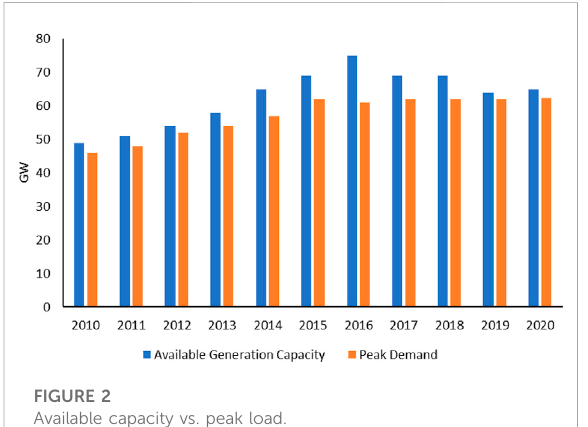
FIGURE 2 Available capacity vs. peak load.